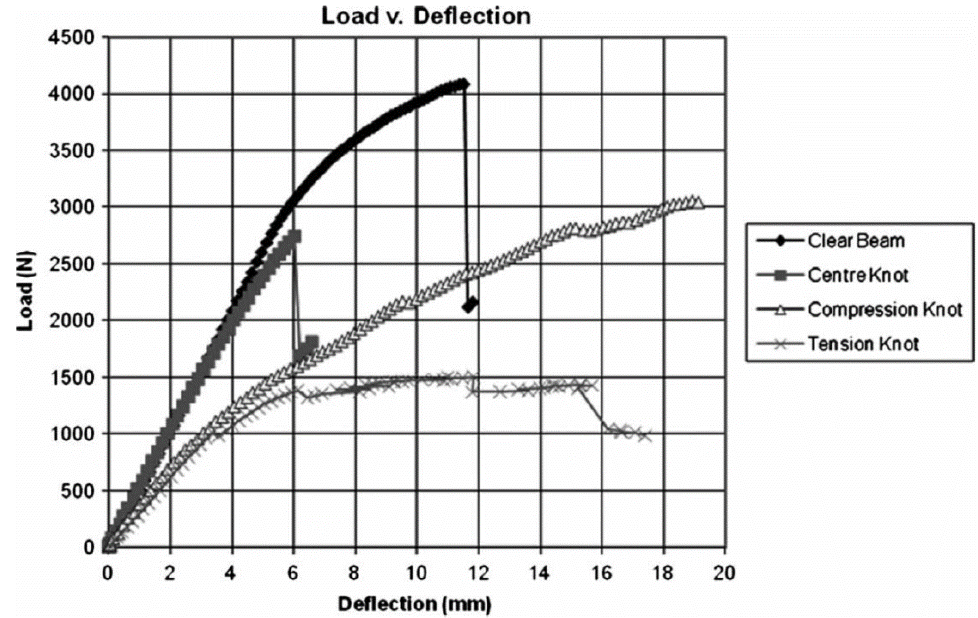
Figure 13. Plot of load version deflection for the beams shown in Figure 12. From [87].